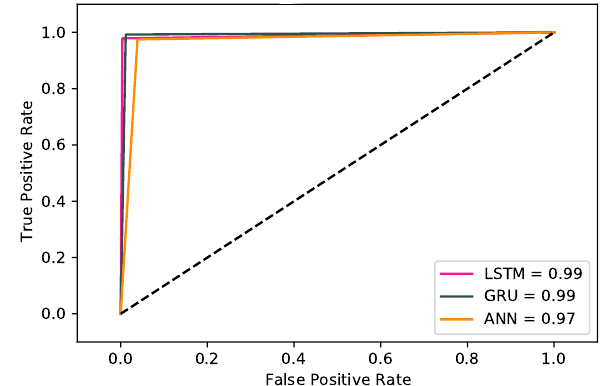
Figure 9. ROC curve for the proposed work.